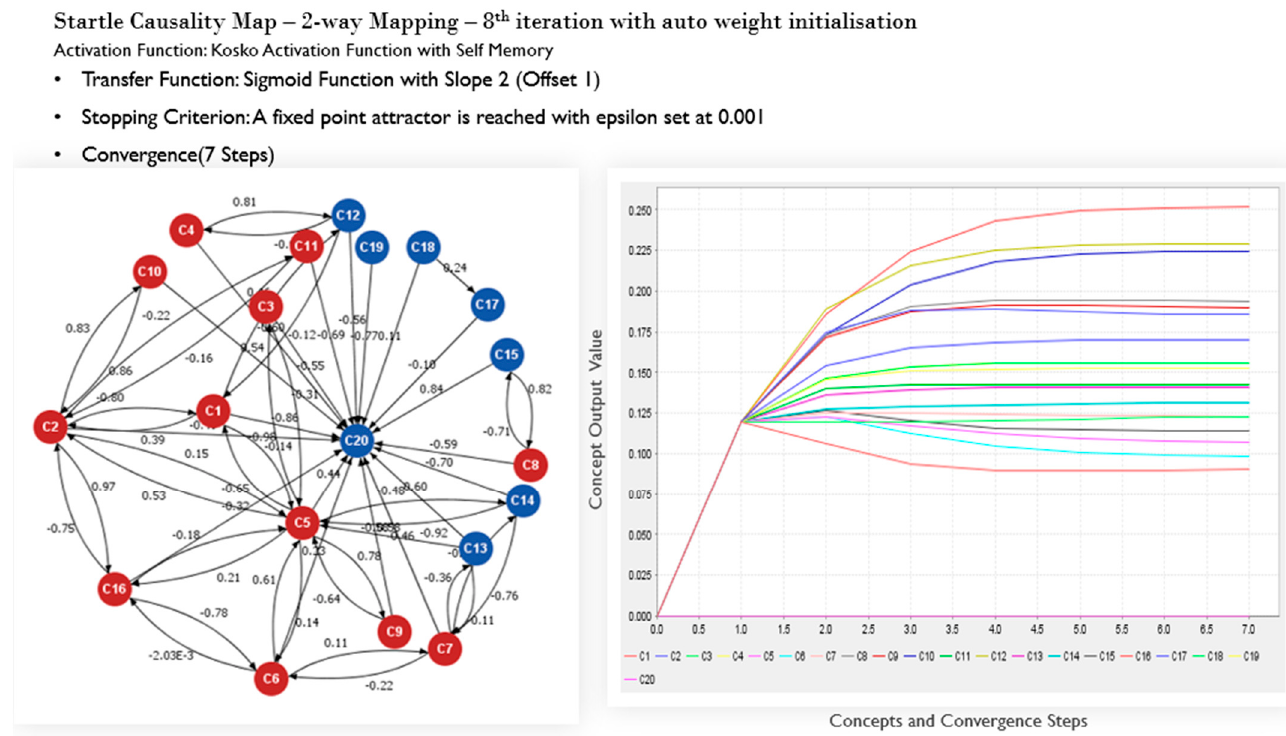
Figure 6. Startle causality map and associated convergence output: showing concepts mapped in both directions, and with initial concepts weights autogenerated through iterations (NOTE: The 8th iteration is shown. Items with 2-way mapping are as per Table 6).